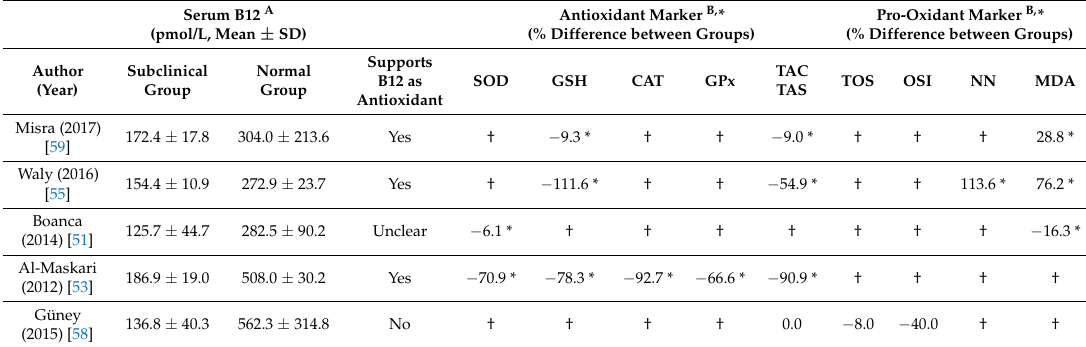
* Indicates a significant difference between groups on this marker as stated by the authors. † Not measured. A: Mean ± SD was estimated according to Hozo et al. if median, range, and sample size were reported [63]. Serum B12 concentrations were calculated in pmol/L using a molecular weight of 1355.388 g/mol if other units were reported [62]. B: Percentage differences were calculated using the standard formula: |(meansubclinical